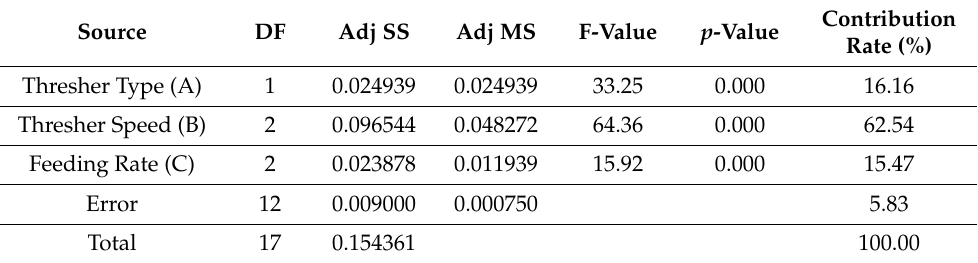
Table 9. ANOVA for